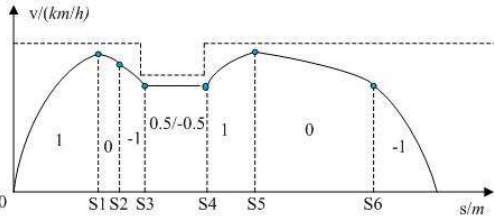
Figure 2. Diagram of train operation mode